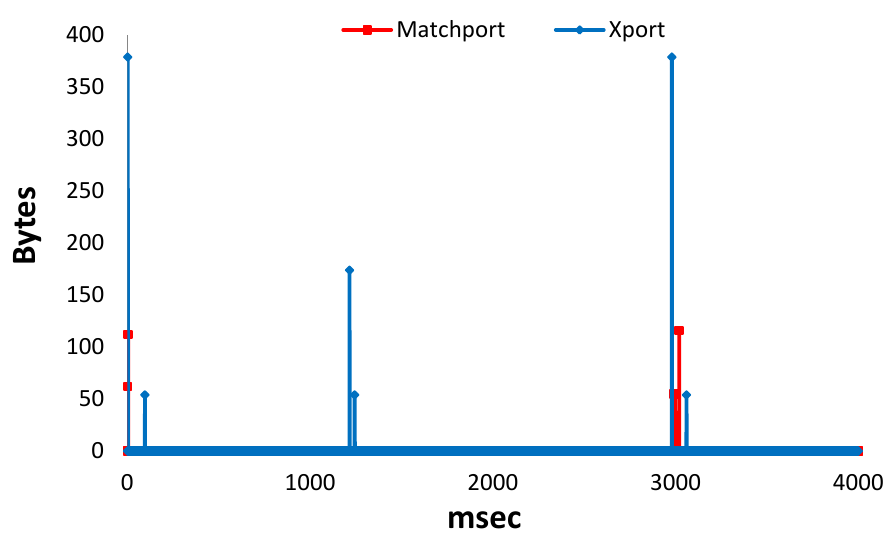
Figure 14. Bytes received per millisecond in proactive